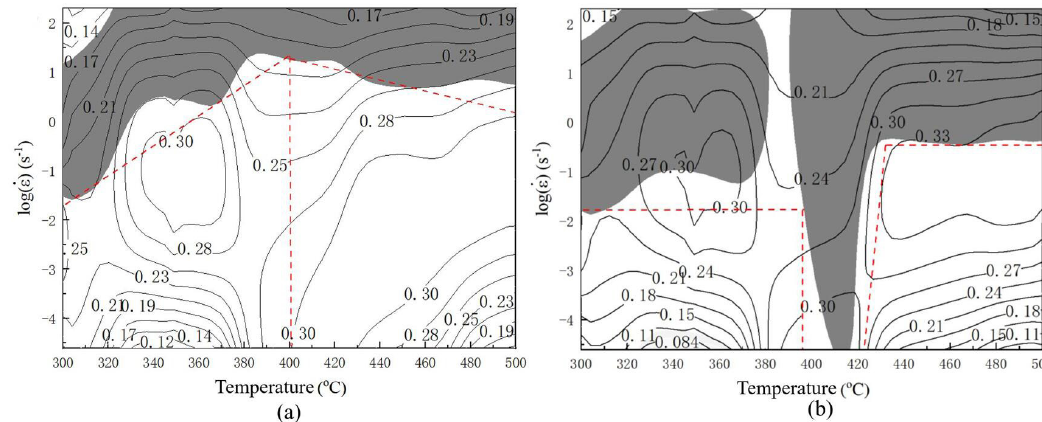
Figure 13. The processing maps at the strain of (a) 0.5 and (b)